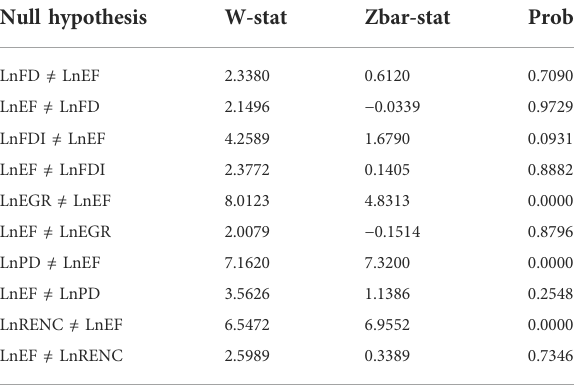
TABLE 7 Dumitrescu hurlin panel causality